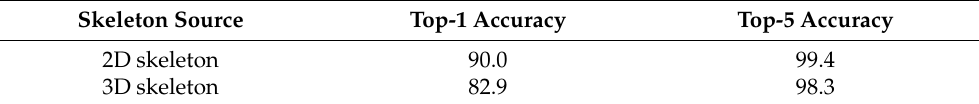
Table 5. The results of 2D and 3D skeletons from the skeleton stream only. The 3D skeletons from NTU RGB+D 60 are reduced to 2D points. Units are in %.